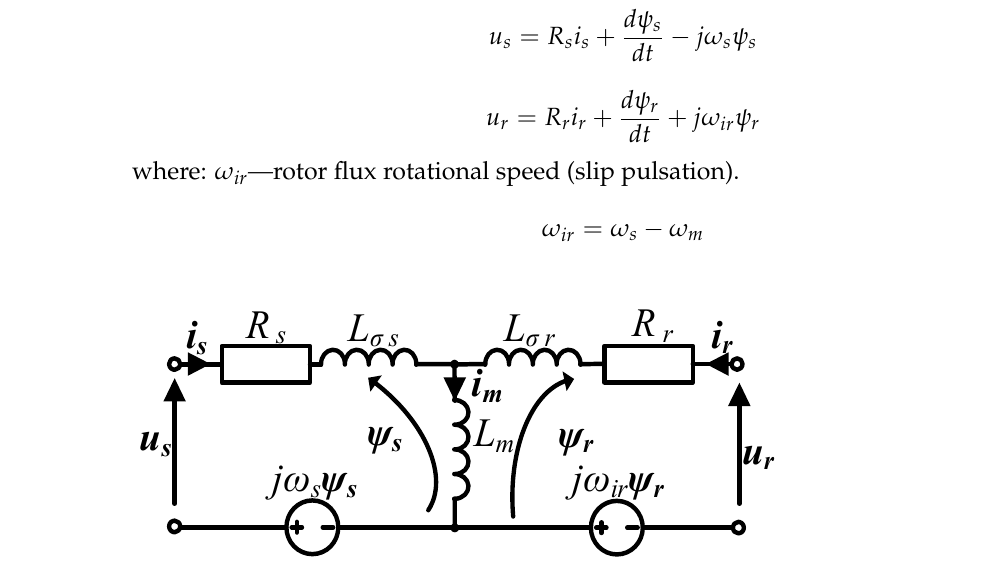
Figure 3. DFIG model in the orthogonal dq rotating frame.